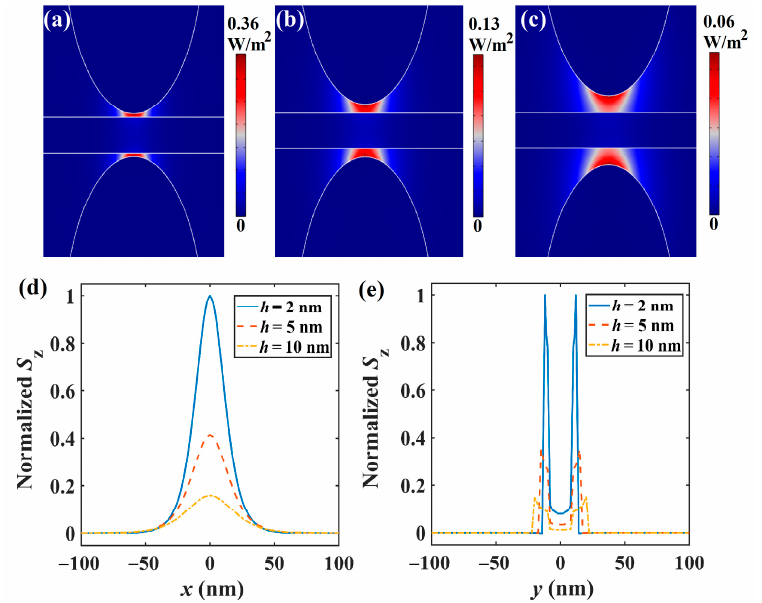
Figure 2. Energy density distribution. ( a – c ) Two-dimensional energy density distributions when h = 2, 5, and 10 nm. ( d – e ) Normalized energy density distributions along the x (at y = 0 nm) and y (at x = 0 nm) directions (shown in Figure 1b).